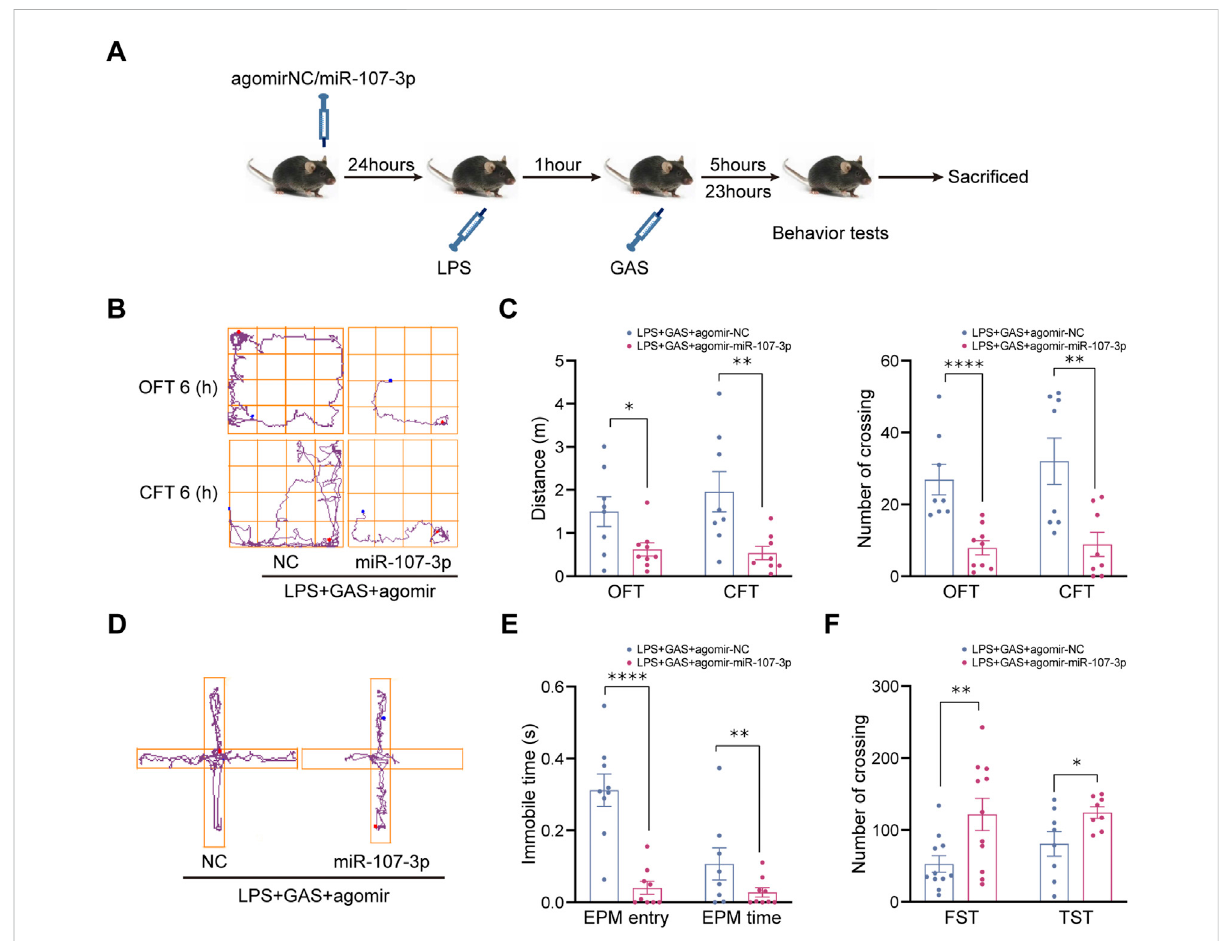
FIGURE 4 Effects of miR-107-3p on depressive-anxiety- like behaviors after LPS and GAS intervention in mice. (A) Flow chart of miR-107-3p agomir injectiononthebehavioraltestsinmice. (B,C) Thetrackmaps,totaldistancetraveled,andcrossinglinesintheOFTandCFT. (D,E) Thetrackmaps,the ratio of the entry and time spent in the open arms in the EPM. (F) The immobile time of swimming and suspension in the FST and TST. Values are represented as means ± SEM. n ≥ 8 each group. **** p < 0.001, ** p < 0.01, * p < 0.05 versus NC group; ## p < 0.01, # p < 0.05 versus LPS + GAS + agomir NC group. LPS, lipopolysaccharide; GAS, gastrodin; OFT, open- fi eld test; CFT, close- fi eld test; FST, forced swimming test; TST, tail suspension test; EPM, elevated plus